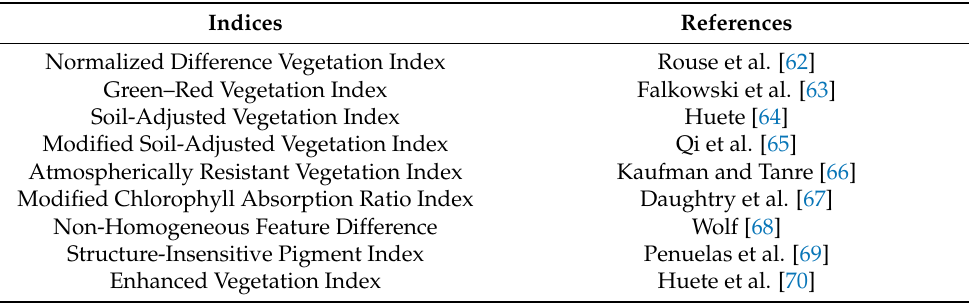
Table 1. Radiometric indices calculated and used in the research.